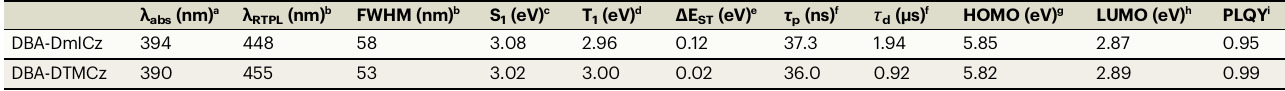
Table 1 | The photophysical and electrochemical properties of DBA-DmICz and DBA-DTMCz λ λ abs (nm) a RTPL (nm) b